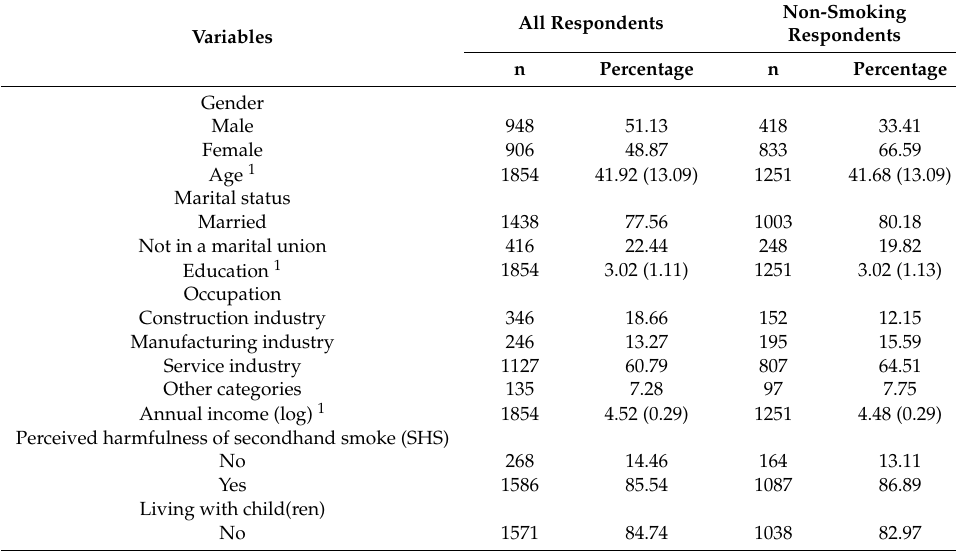
Table 1. Sociodemographic characteristics of